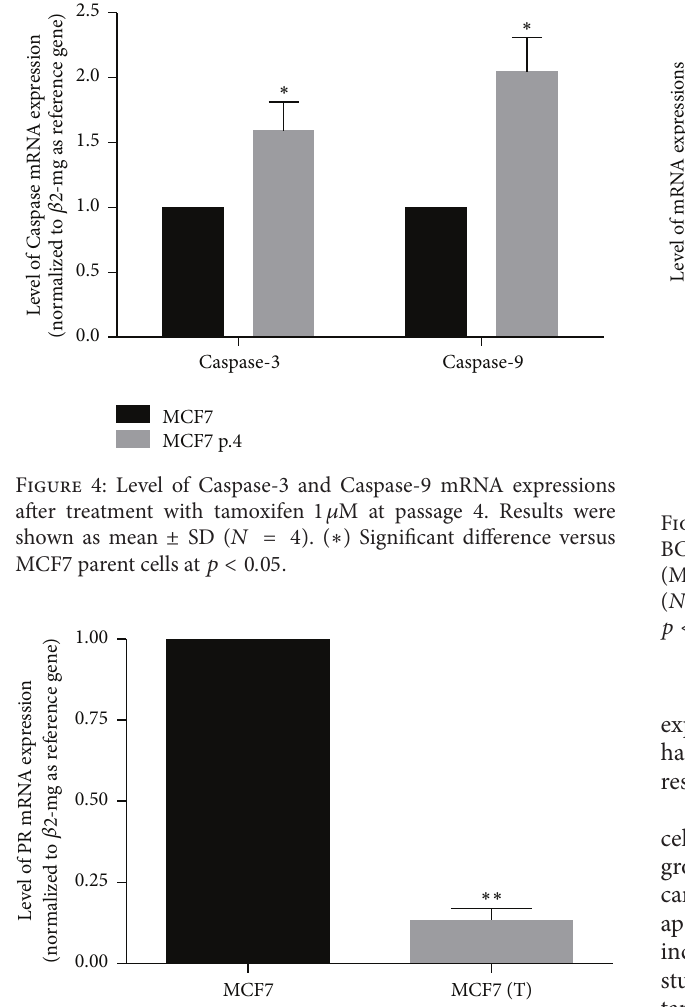
Figure 5: Level of progesterone receptor expressions after 44 days of treatment with tamoxifen 1 𝜇 M MCF7 (T). Results were shown as mean ± SD ( 𝑁 = 4 ). ( ∗∗ ) Significant difference versus MCF7 parent cells at 𝑝 < 0.001 .